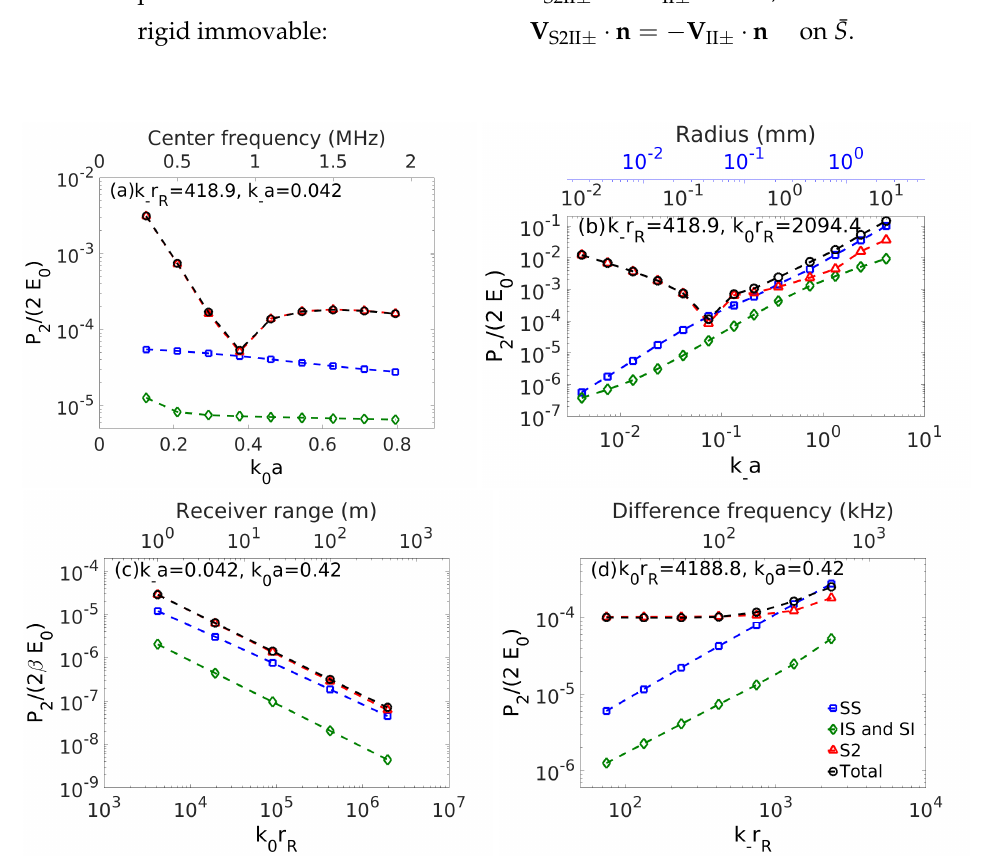
Figure 6. A pressure release sphere with collinear incident waves propagating in ˆ i z . The difference frequency component of p 2 is calculated at r R = − r R ˆ i z as a function of ( a ) center frequency or k 0 a , ( b ) object radius or k − a , ( c ) receiver range or k 0 r R , and ( d ) difference frequency or k − r R . Lower dimensionless abscissas are for general interpretations. Upper black abscissas are for a medical or underwater sensing example of 1 MHz primary and 100 kHz difference frequencies with 0.1 mm sphere radius at 1 m range from the receiver with 1500 m/s sound speed. The upper blue abscissa in ( b ) is for different medical or underwater sensing example of 2 MHz primary and 400 kHz difference frequencies with 0.1 mm sphere radius at 0.25 m range with 1500 m/s sound speed. In ( a ), p S2 is dominant. In ( b ), p S2 dominates for small k 0 a , p SS becomes comparable to p S2 for k 0 a near 1 then transitions to dominance for k 0 a > 1. In ( c ), p S2 is dominant, but p SS will dominate as range increases. In ( d ), p S2 dominates for small k − r R , and p SS becomes comparable to p S2 for large k − r R . The nonlinear parameter is β =